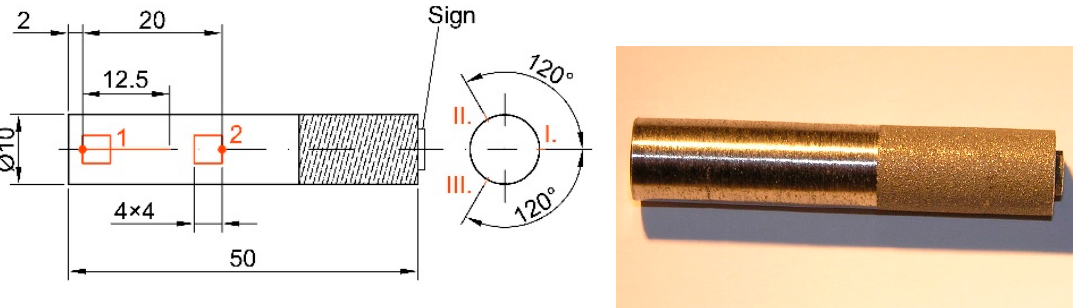
Figure 4. The roughness measurement locations on the specimen.